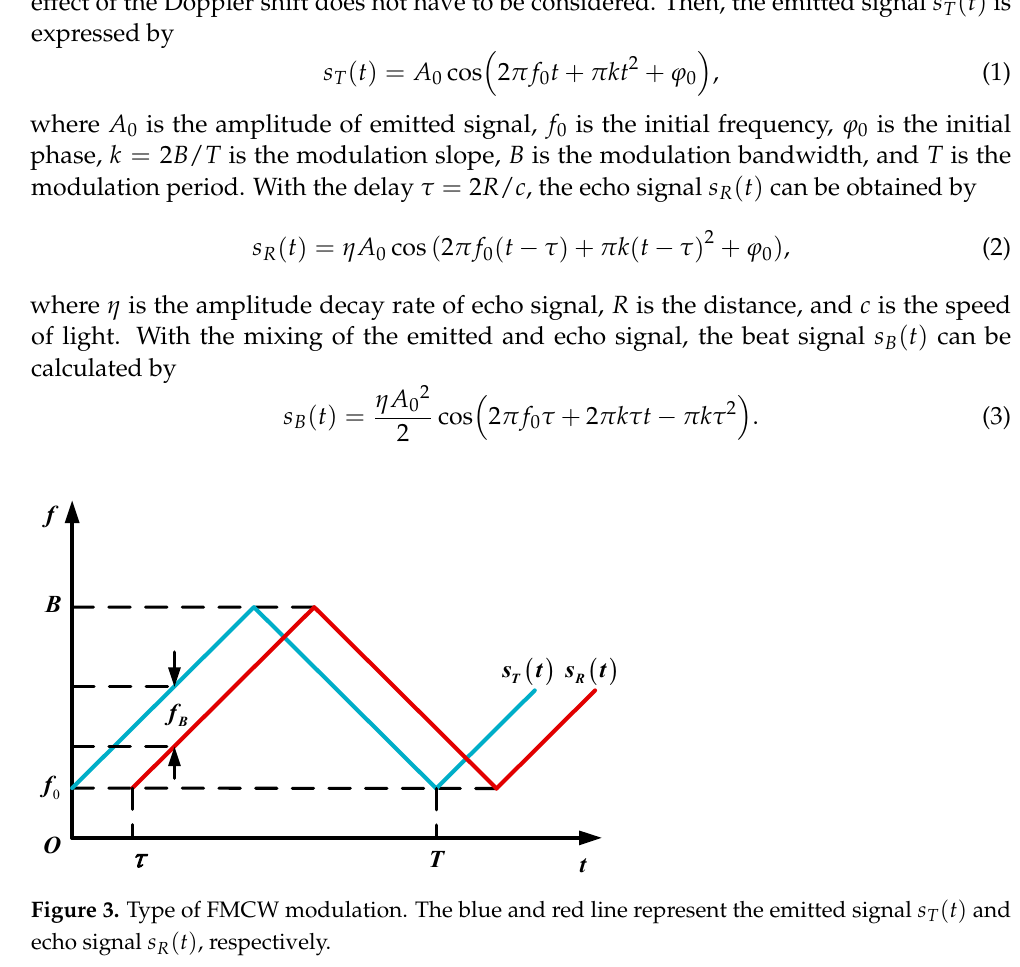
B f Figure 4. Process of DFBDWC algorithm. The input and output of this algorithm are the beat signal and frequency value of the beat signal, respectively. WGN is a kind of noise whose probability density function satisfies the statistical characteristics of normal distribution and whose power spectral density function is con- stant. The most noteworthy feature of it is that the signal contains all frequency compo- nents from negative infinity to positive infinity, so it can be apparently distinguished from useful signals with a spectral peak in the spectrum. Accordingly, a similar sequence of WGN can be decomposed from the beat signal. First, decomposition is a new method based on empirical mode decomposition (EMD) [28–30] that is a direct extraction of the energy associated with various intrinsic time scales and the most important parameters of the system. After processing with EMD, a signal can be expressed as a sum of amplitude- and frequency-modulated functions called modes. Each mode is intrinsic and has unique characteristics in the frequency do- main, which means several of them enable the estimation of WGN. However, there are some phenomena in EMD, such as oscillations with very disparate scales in one mode or oscillations with similar scales in different modes. These phenomena will cause a problem called “mode mixing”, and some decomposed modes, strictly speaking, will not be a sin- gle component signal, so it is not conducive to estimate the noise component accurately.